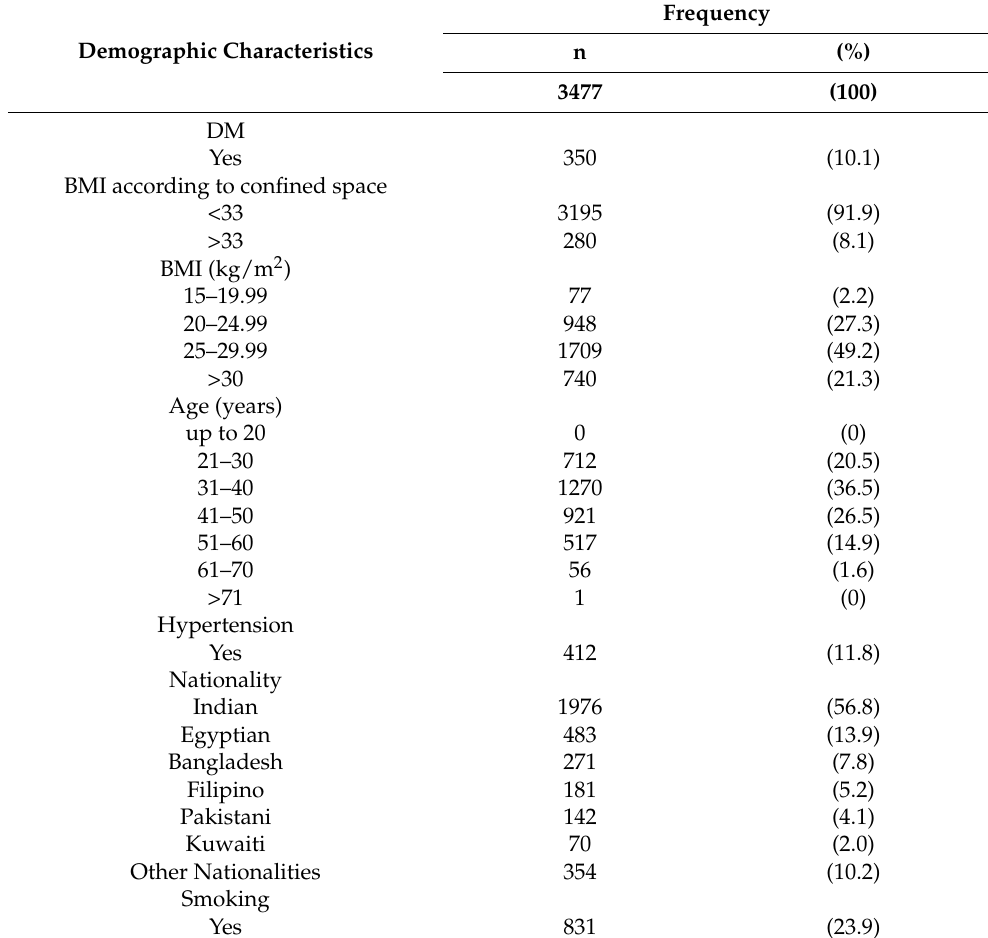
Table 1. Diabetes mellitus and demographic characteristics of the study participants from SIMC dataset, Kuwait,